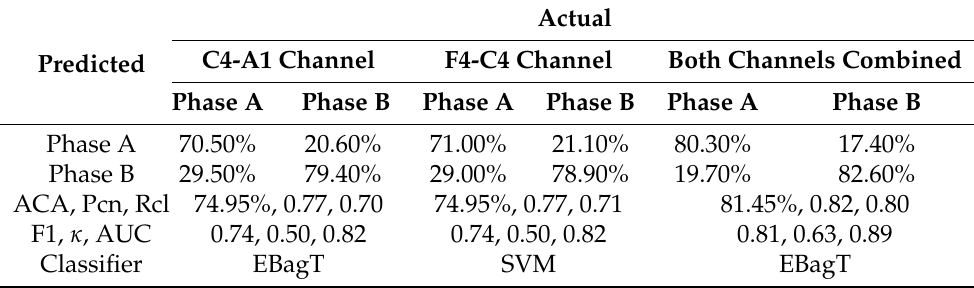
Table 10. Classification performance for SDB subjects.